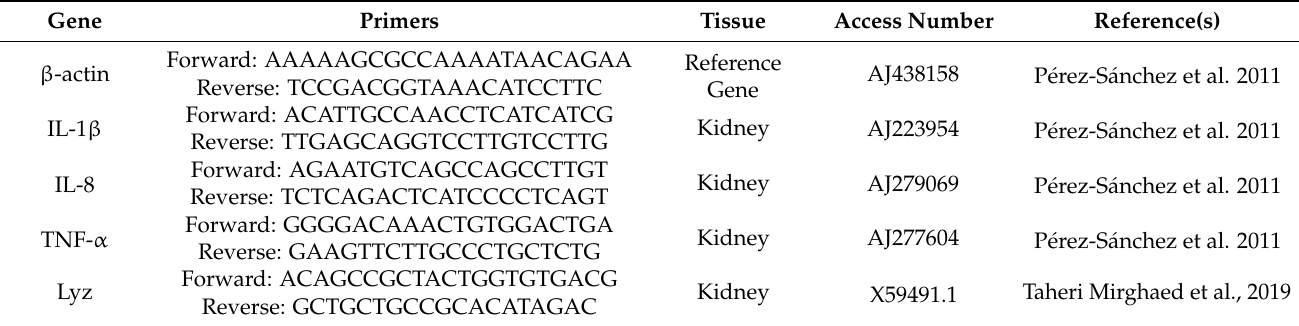
Table 2. Sequence of primers used for gene